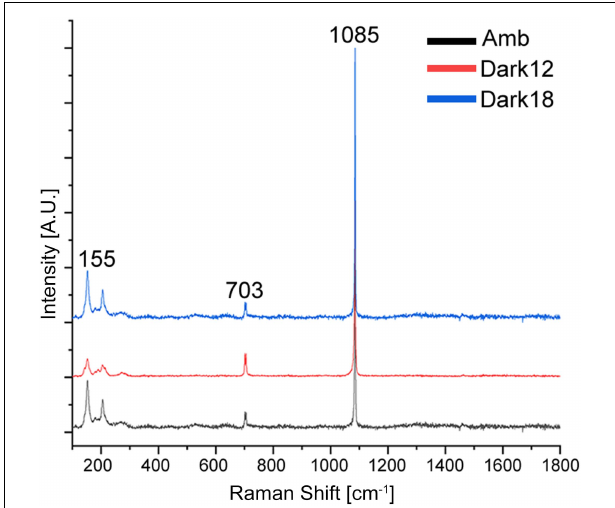
FIGURE 7 | Raman measurements of aragonite minerals in O. patagonica corallites. Average spectra for colonies grown under ambient (black) and bleaching conditions, measured after 12 (red) and 18 (blue) months. Samples spectra correspond to aragonite, with the known peaks overlapping at ∼ 155–280, ∼ 703 and ∼ 1085 cm − 1 .